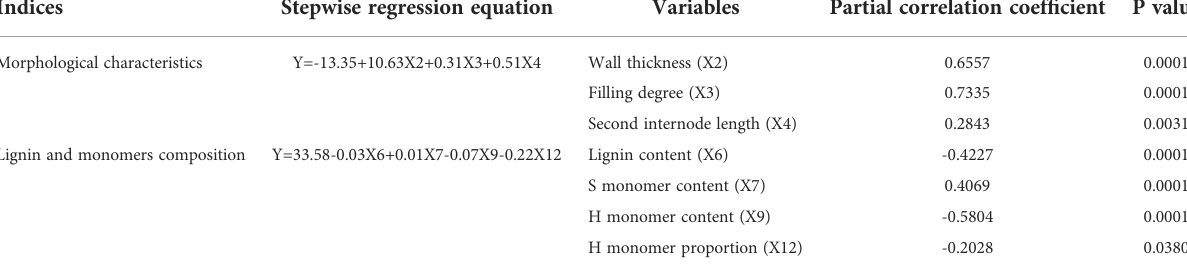
TABLE 1 Stepwise regression analysis between wheat stem morphological indices, lignin monomers composition and breaking strength.